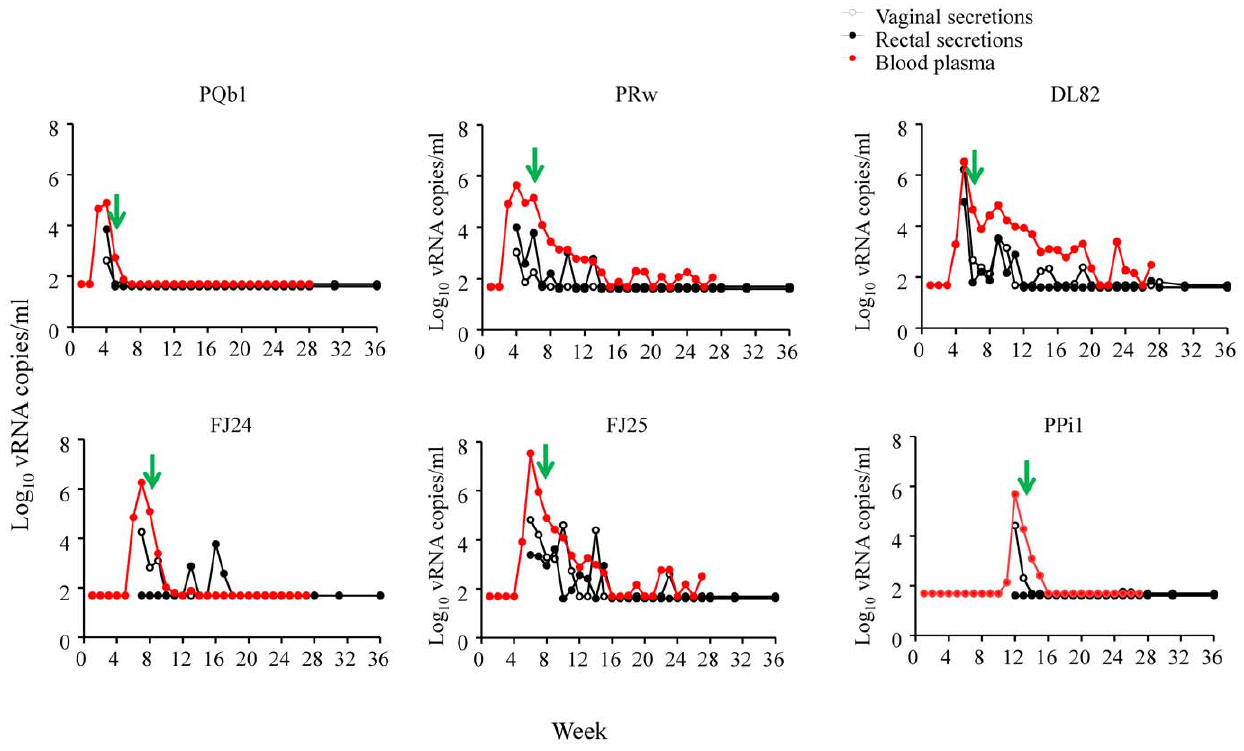
Figure 5. Plasma viremia, rectal and vaginal shedding, and seroconversion in infected placebo controls. SHIV RNA levels in plasma (red circles), vaginal secretions (open circle), and rectal secretions (closed cycles) were measured weekly for up to 38 weeks after the first virus challenge. Exposures were stopped when a macaque became SHIV RNA positive in plasma. The first detectable antibody response is shown as a green arrow.